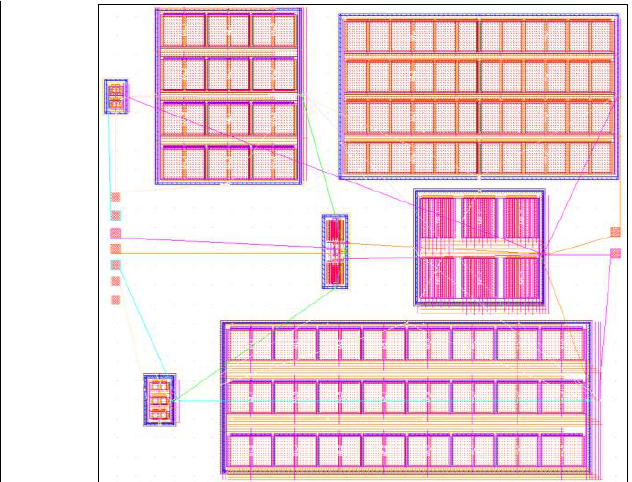
Figure 8. Amplifier with the building blocks generated. The schematic is depicted on the left (vector graphic which is derived from the actual design view) and the initial, unconnected layout with full building block layouts is depicted on the right (manually placed according to the schematic posi- tions). All building block layouts are automated by generators based on layout parameters that can be controlled already during schematic-level design entry.